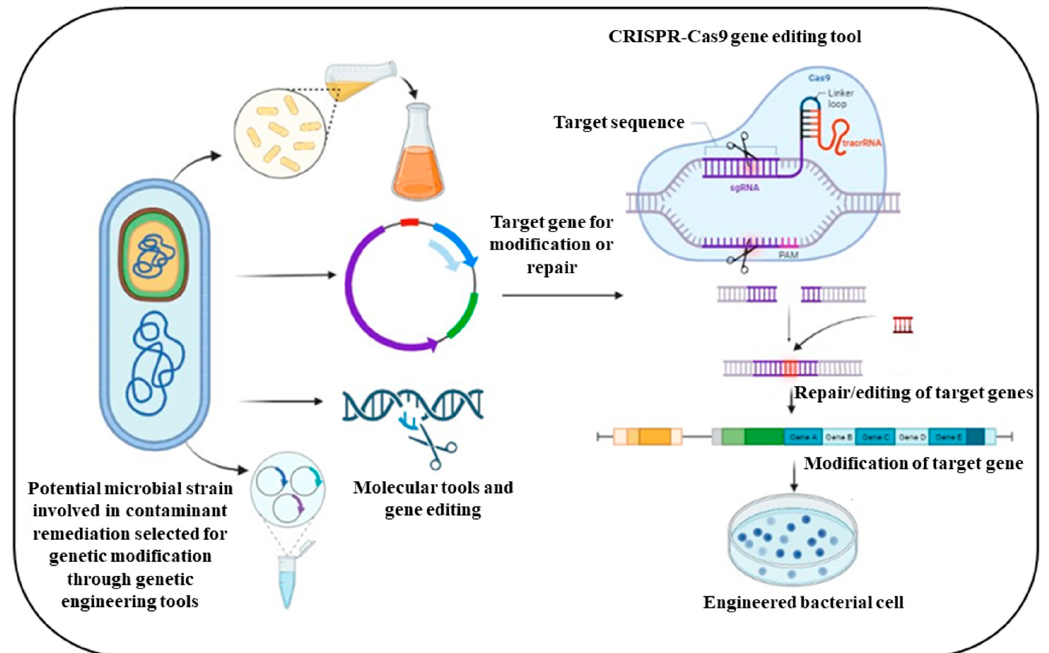
Figure 4. Illustration of genetic editing tools employed to modify and reconstruct target genes for metabolic pathway engineering in specific bacterial species. The microbes with high degradation efficiency are selected, and through cloning and other gene editing tools (TALEN, ZFNs, and CRISPR-Cas9), the efficiency of hydrocarbon degradation and its bioprocessing may be accelerated.